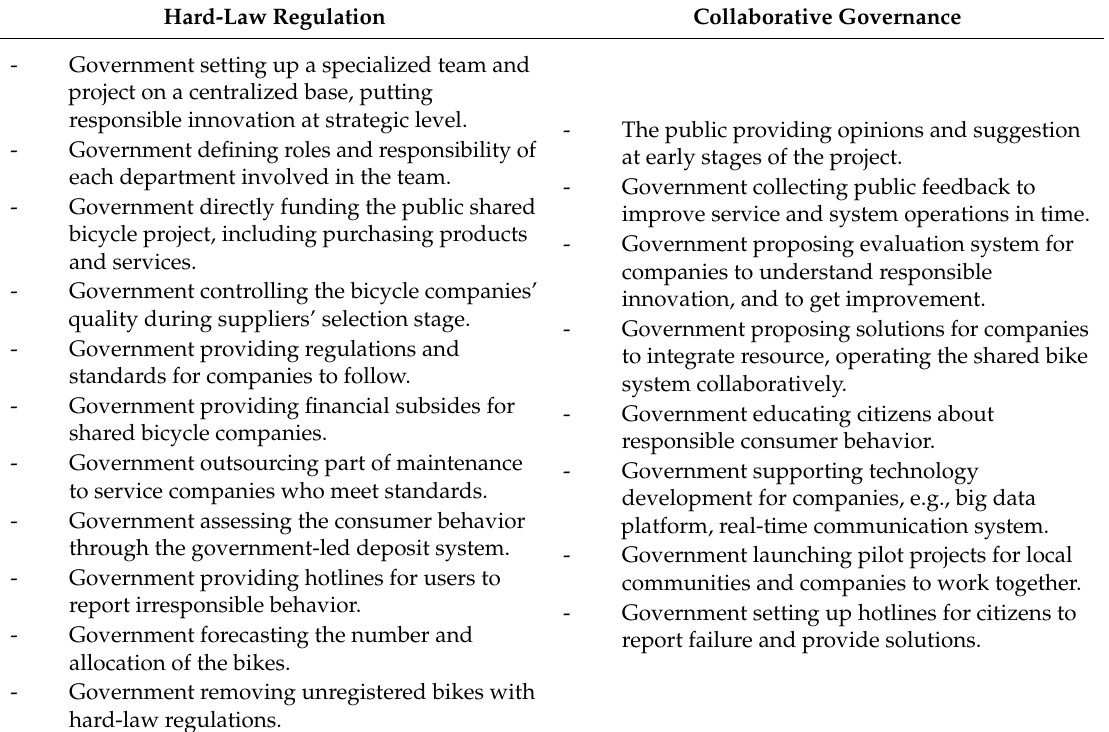
Table 2. Government policies in the context of hard-law regulation and governance.